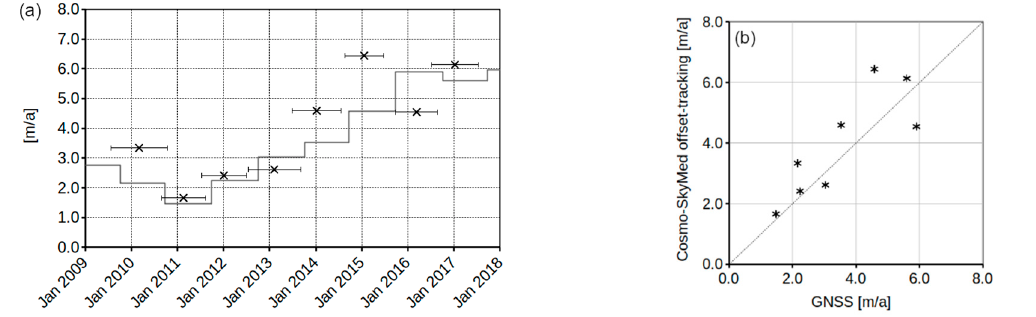
Figure 18. ( a ) Horizontal velocities from GNSS campaigns carried out seasonally (grey line) and Cosmo-SkyMed offset tracking (black stars) on the central sector of the Tsarmine rock glacier (Val d'Arolla, Switzerland, for position see Figure 4); ( b ) Scatter plot of GNSS and Cosmo-SkyMed offset tracking horizontal velocities.